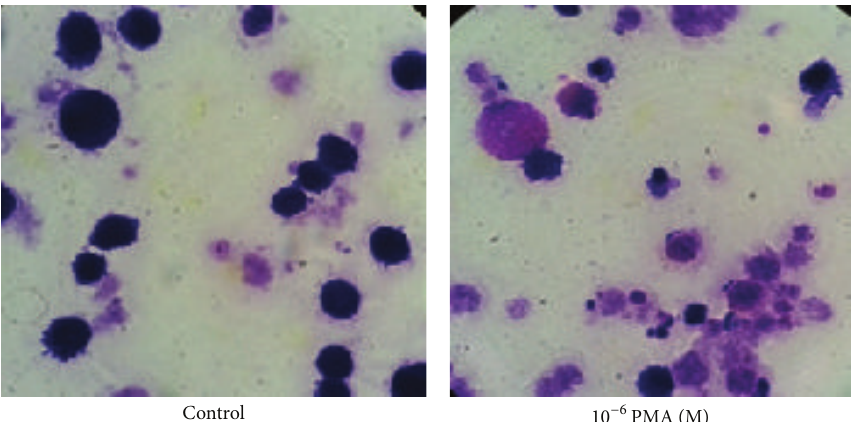
Figure 3: TF-1a cells stained with DIPP Quick Stains. TF-1a cells were treated with PMA for 48 hours, after which the cells were collected and slides were prepared following the method described in Section 2. The staining method followed manufacture’s instruction ( ×